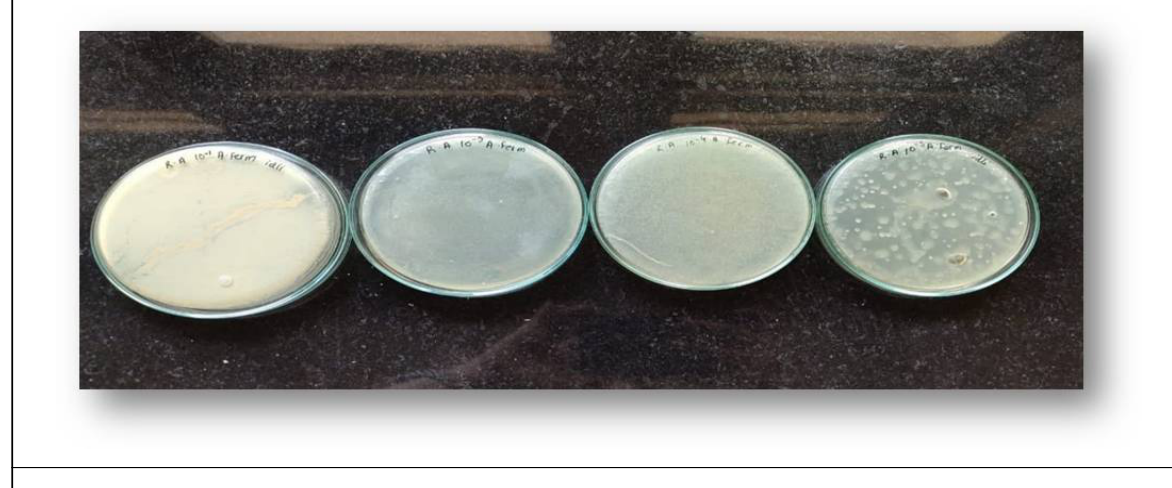
Figure 3. Spread plate of dilutions on Rogosa agar